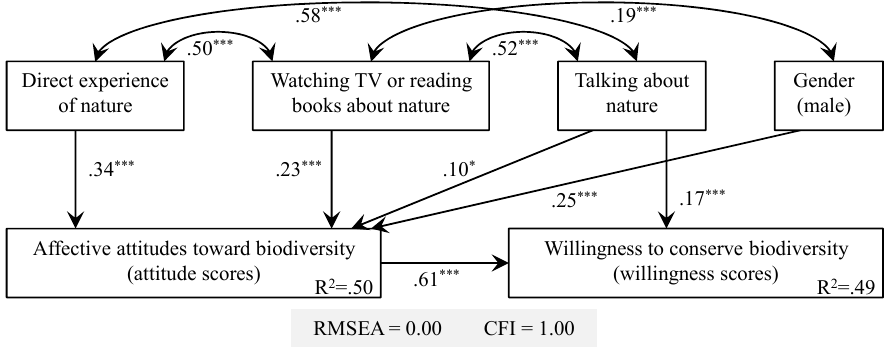
Figure 3. Model with standardized estimates of parameters (non-significant paths were omitted) predicting children’s attitudes toward (attitude scores) and willingness to conserve biodiversity (willingness scores). Asterisks indicate the significance levels ( * p < 0.05; ** p < 0.01; *** p < 0.001).